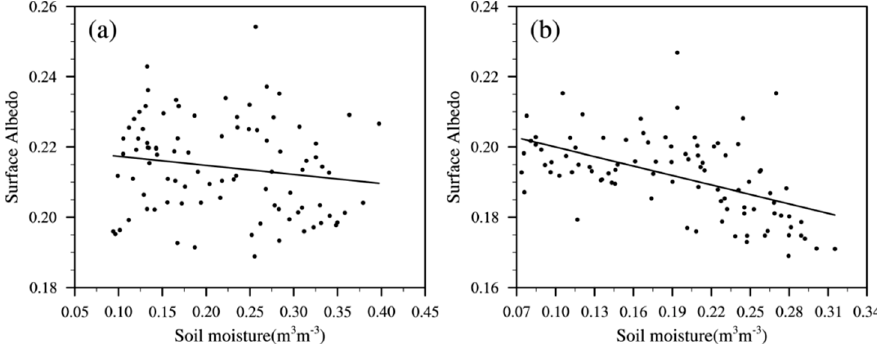
Figure 9. The relationship between daily ground-based albedo and soil moisture (units: m 3 m − 3 ) at 5 cm depth from June to August at ( a ) Maqu site in 2014 and ( b ) Maduo site in 2012. The solid line is the fitted relation.